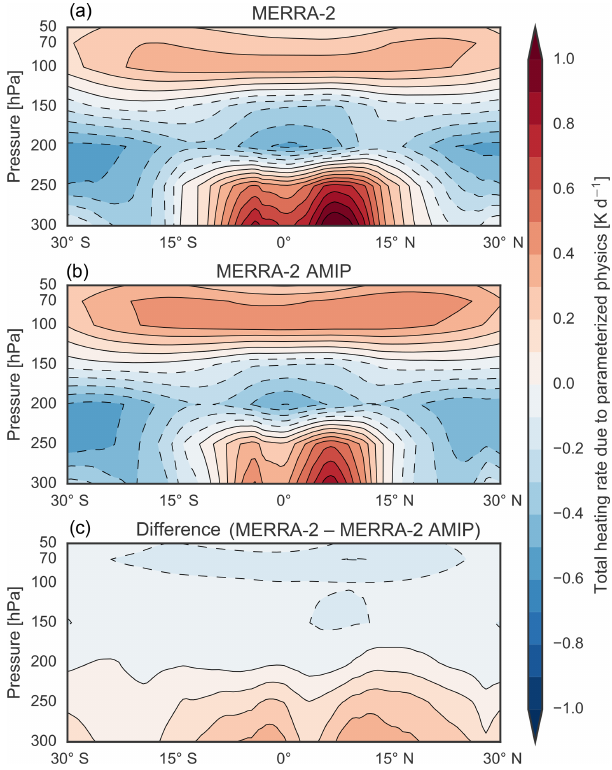
Figure D1. Comparison of time-mean zonal-mean diabatic heat- ing rates in the tropical (30 ◦ N–30 ◦ S) lower stratosphere between the MERRA-2 reanalysis (a) and the MERRA-2 AMIP ensemble mean (b) over 1980–2017. Differences between MERRA-2 and MERRA-2 AMIP are shown in (c)